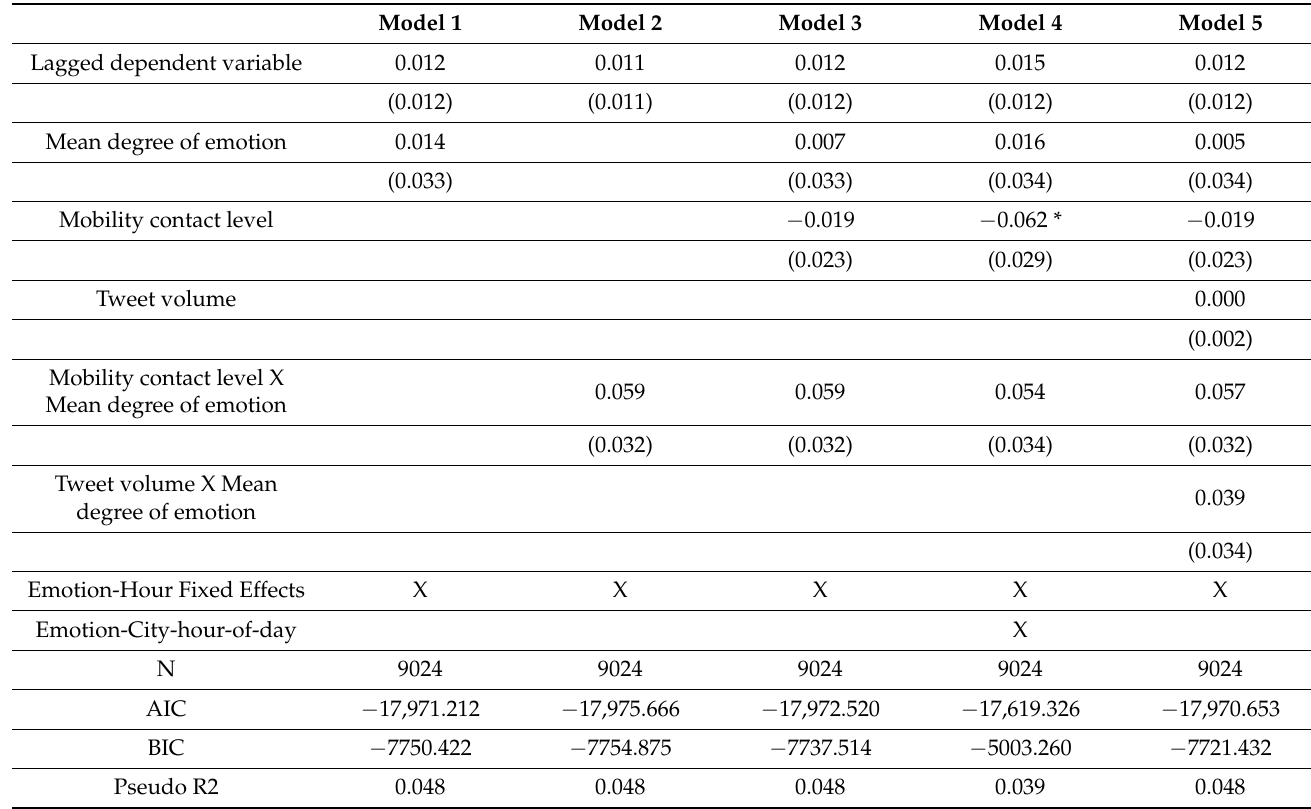
Table 6. Negative emotion models.